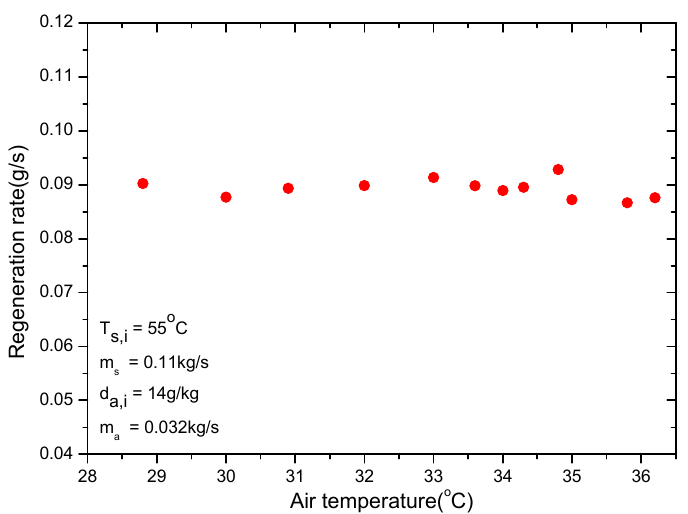
Figure 4. Influence of air temperature on regeneration.